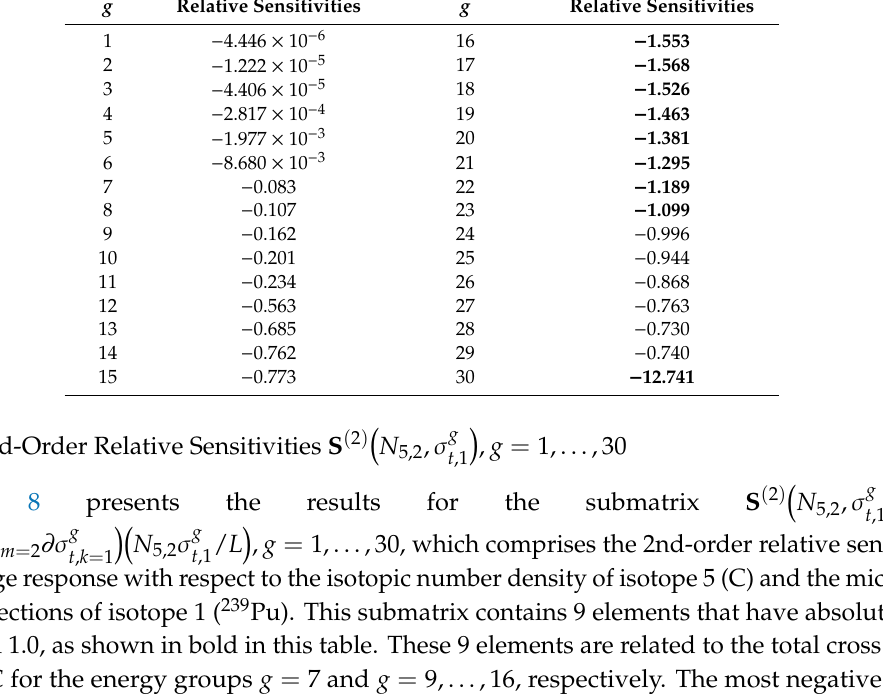
Table 7. Second-Order Relative Sensitivities S ( 2 ) g Relative Sensitivities g